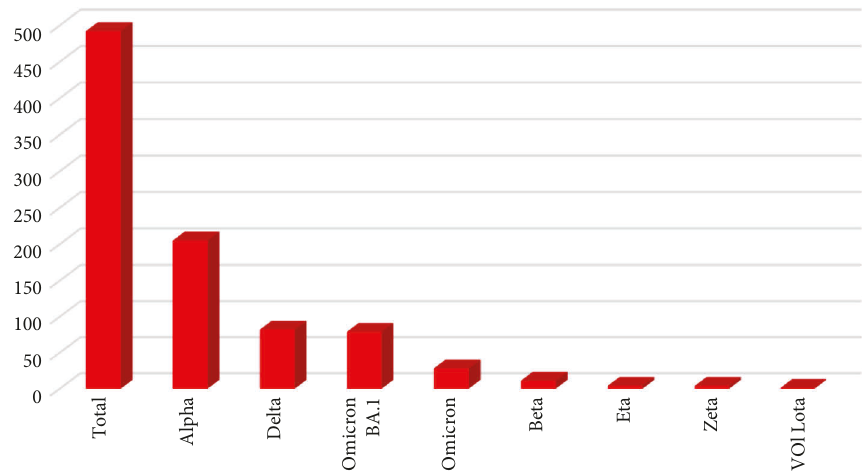
Figure 1: SARS-CoV-2 variant distribution in